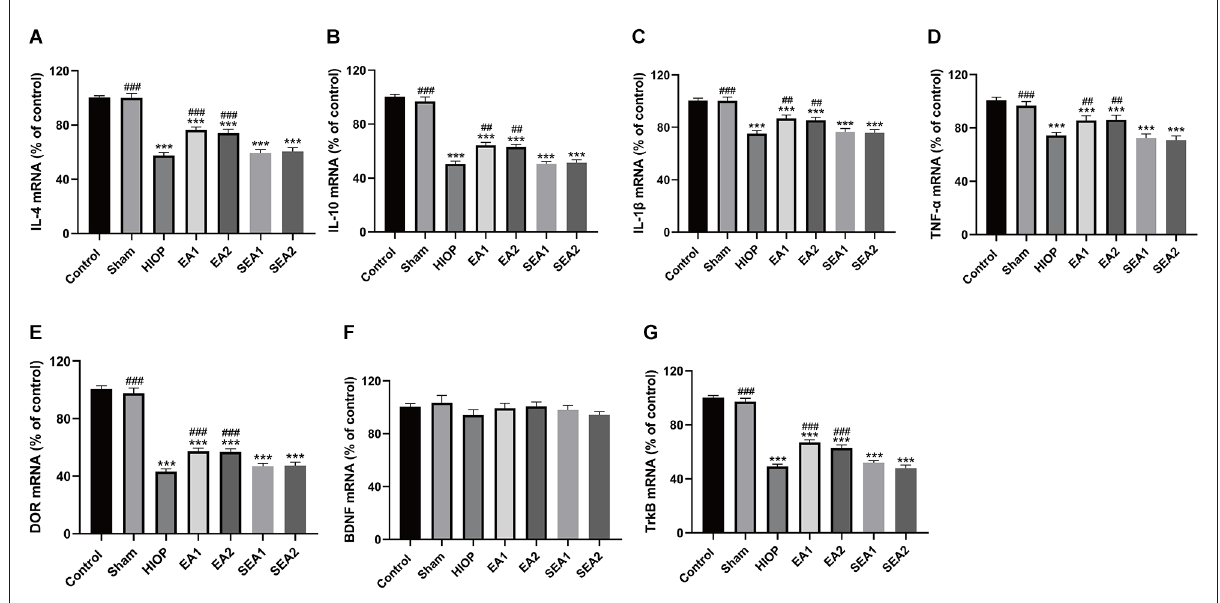
FIGURE8 EA can activate DOR and elevate DOR and TrkB expression to reduce the inflammatory response after RIRI for 7 days. (A–D) The mRNA expression levels of proinflammatory cytokines (TNF- α and IL-1 β ) and anti-inflammatory cytokines (IL-4 and IL-10) were evaluated by RT–qPCR at 7 days of reperfusion following 1 h of retinal ischemia. (E–G) The mRNA expression levels of DOR, BDNF, and TrkB were evaluated by RT–qPCR at 7 days of reperfusion following 1 h of retinal ischemia. The data are expressed as the mean ± SEM (*** P < 0.001 vs. the control group; ## P < 0.01, ### P < 0.001 vs. the HIOP group; n = 6 for each